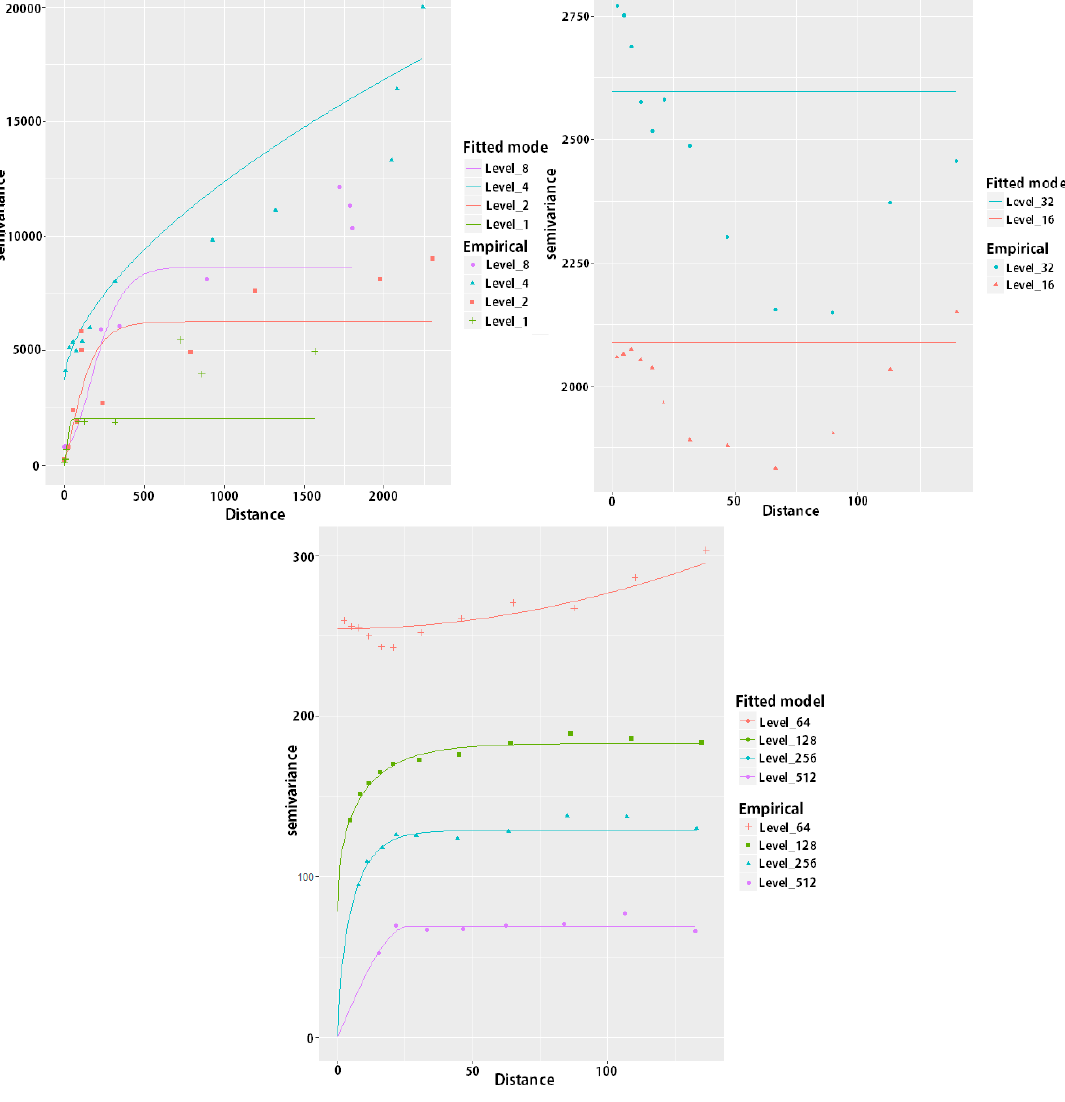
Table 4. Parameters of the fitted variogram models.